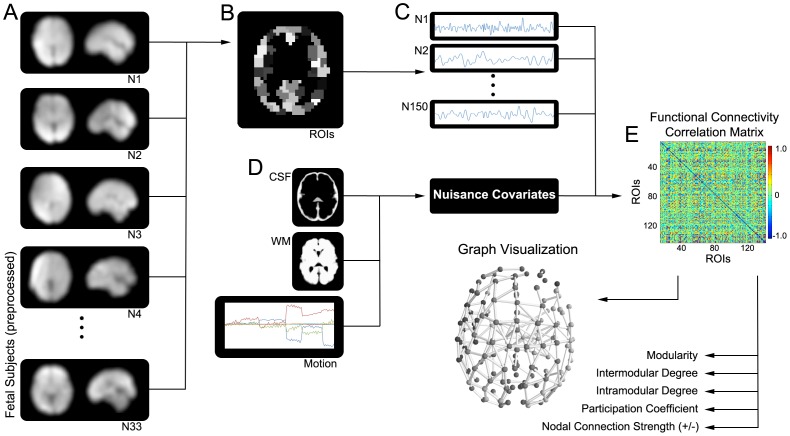
Fetal fMRI graph processing pipeline.33 preprocessed fetal fMRI datasets (A) were divided into 149 distinct regions of interest (B), from which regional blood oxygen level dependent (BOLD) timeseries was extracted (C). After removing principal components of signals from cerebrospinal fluid (CSF), gray matter (GM), and white matter (WM), as well as the translational and rotational movement parameters (D), timeseries were correlated with one another in pairwise fashion to derive a 149×149 correlation matrix (E), which was used to assess graph metrics (e.g., modularity) and to derive graph visualizations of human fetal brain networks.